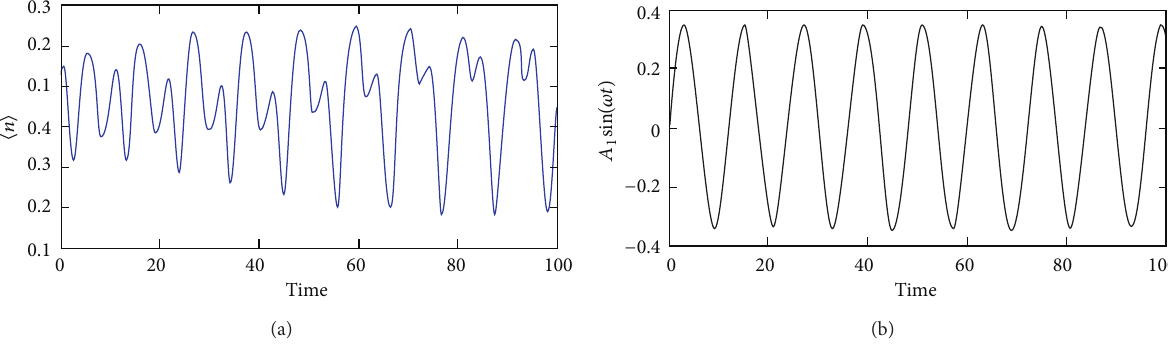
Figure 7: The 2 : 1 frequency-locking oscillation with the values of the parameters 𝐴 1 = 0.35 , 𝜔 = 𝜋/6 , 𝜀 = 0.3 , and 𝜏 = 11 . (a) The mean concentration of vegetation; (b) periodic forces.